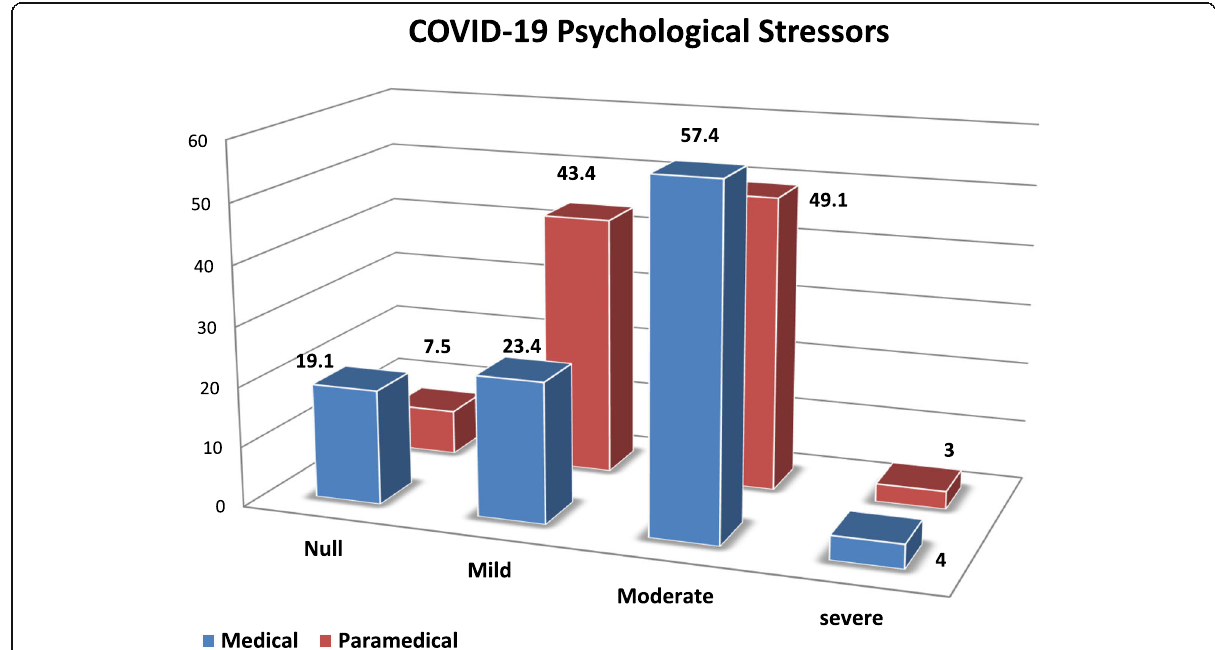
Fig. 2 COVID-19 psychological stress levels of studied staff (medical and paramedical) ( n = 364)